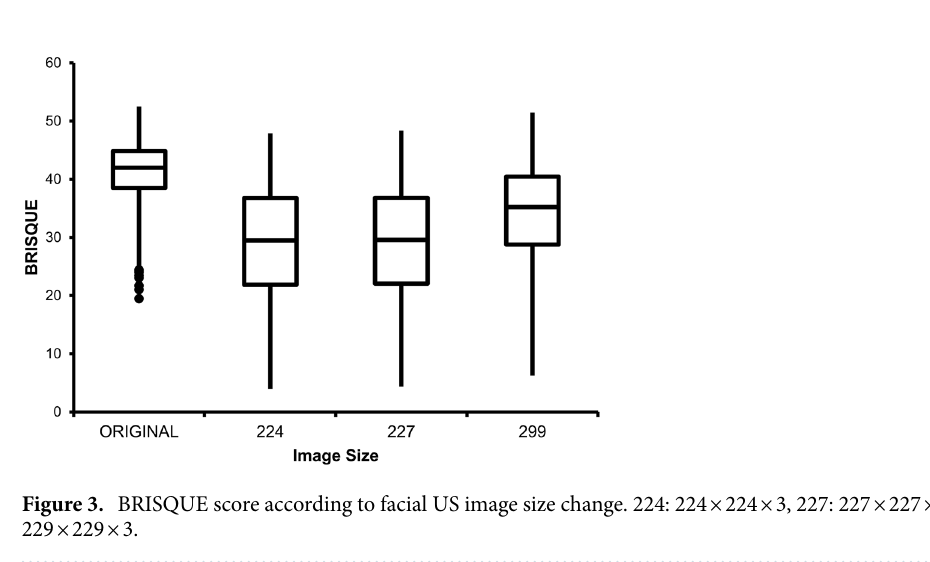
Figure 2. Scatter plot of facial US images’ size.